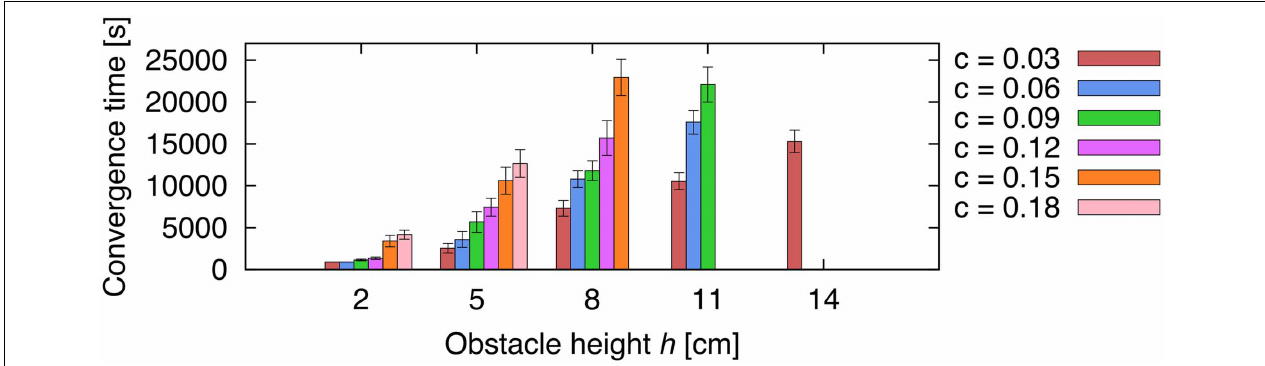
FIGURE 10 | Average convergence times for five selected heights using different gaits. Five different obstacle heights ( h = 2 , 5 , 8 , 11 , 14cm) were selected using the set of gait parameter as described in Figure 9 to compare the average convergence times ( ± SD) of 20 learning trials.